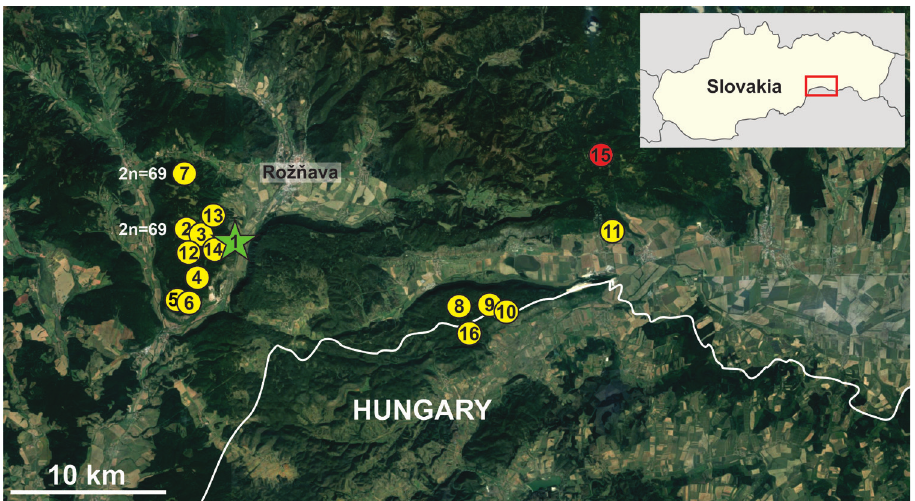
Figure 2. Distribution of Neobisium slovacum in karst in Slovakia and Hungary. Green star indicates the type locality and red spot the northernmost locality of the subgenus Blothrus . The karyotype is recorded for two localities. Localities numbered as in Table